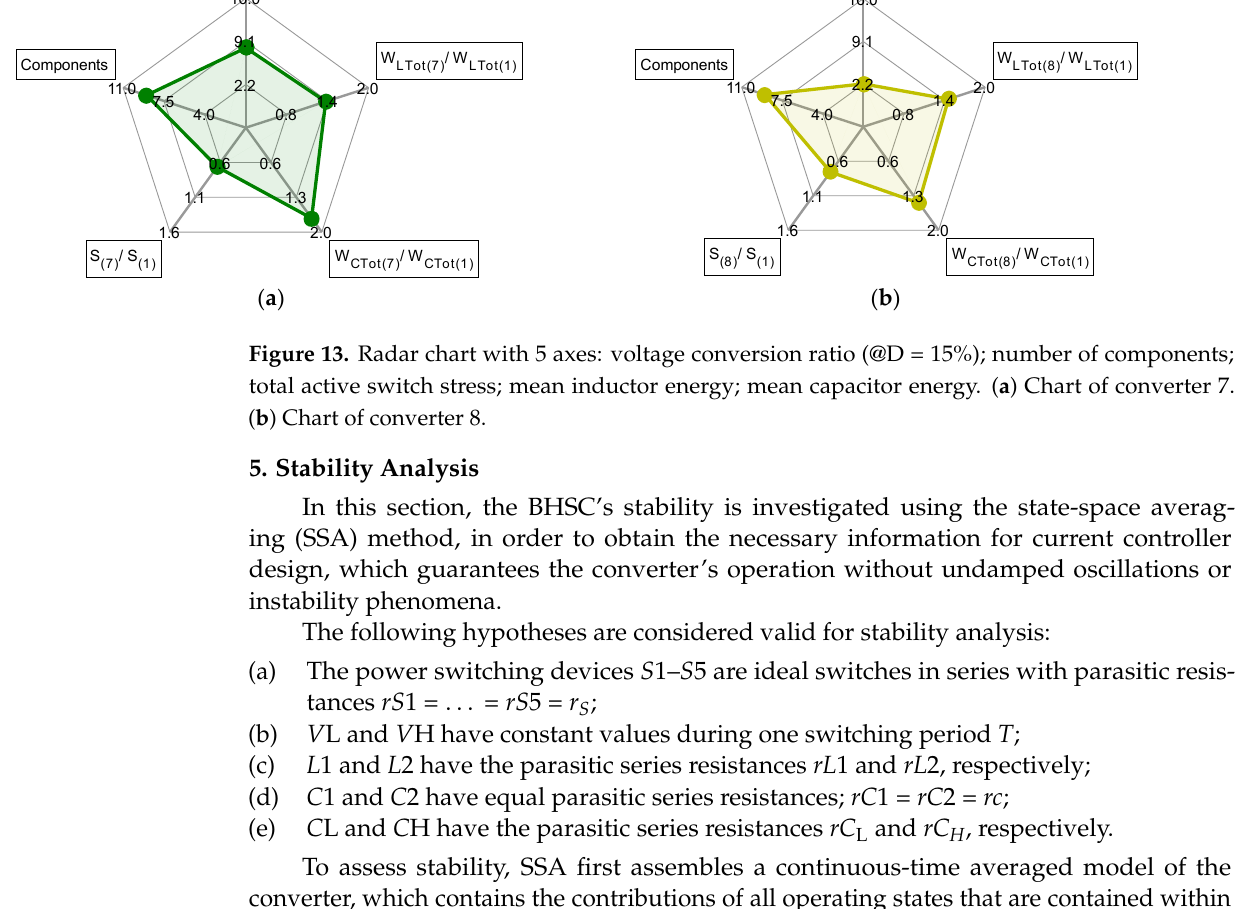
Figure 15. Equivalent BHSC schematic, derived from Figure 14, for t on . Figure 16. Equivalent BHSC schematic, derived from Figure 14, for t off . The input and input vector are defined as follows: 1